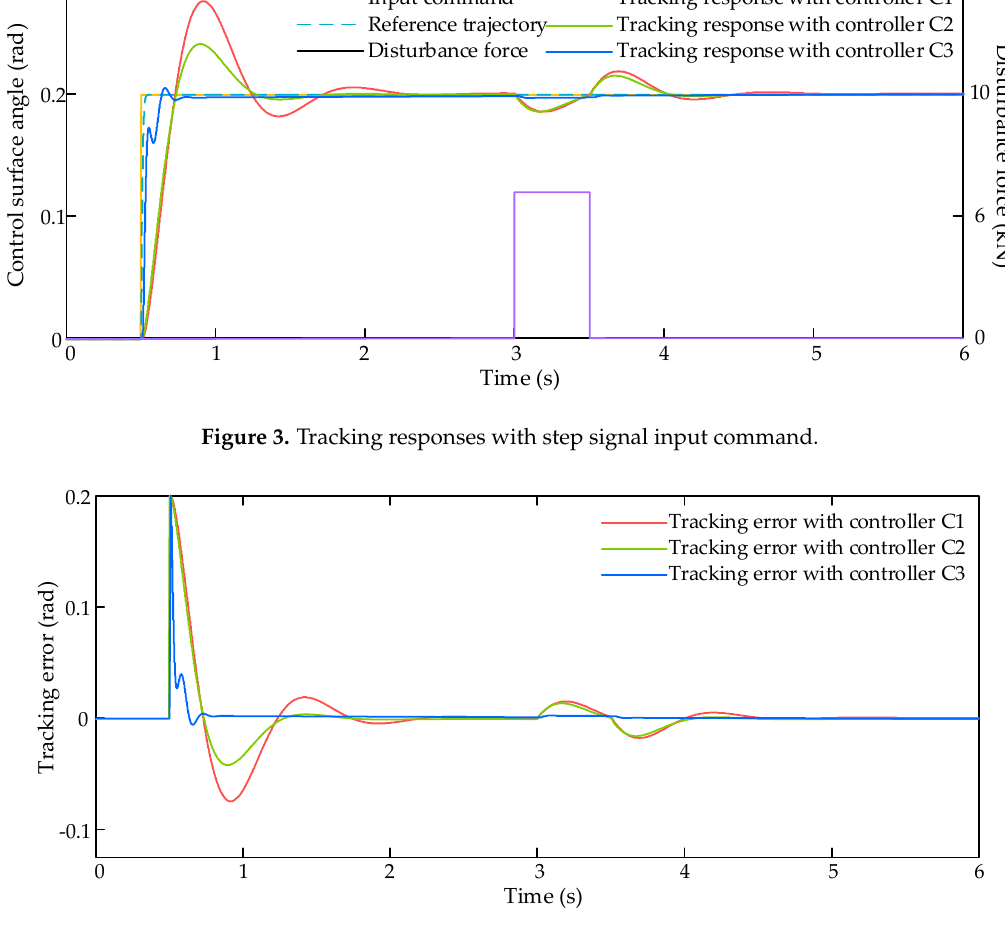
Figure 4. Tracking errors with step signal input command.